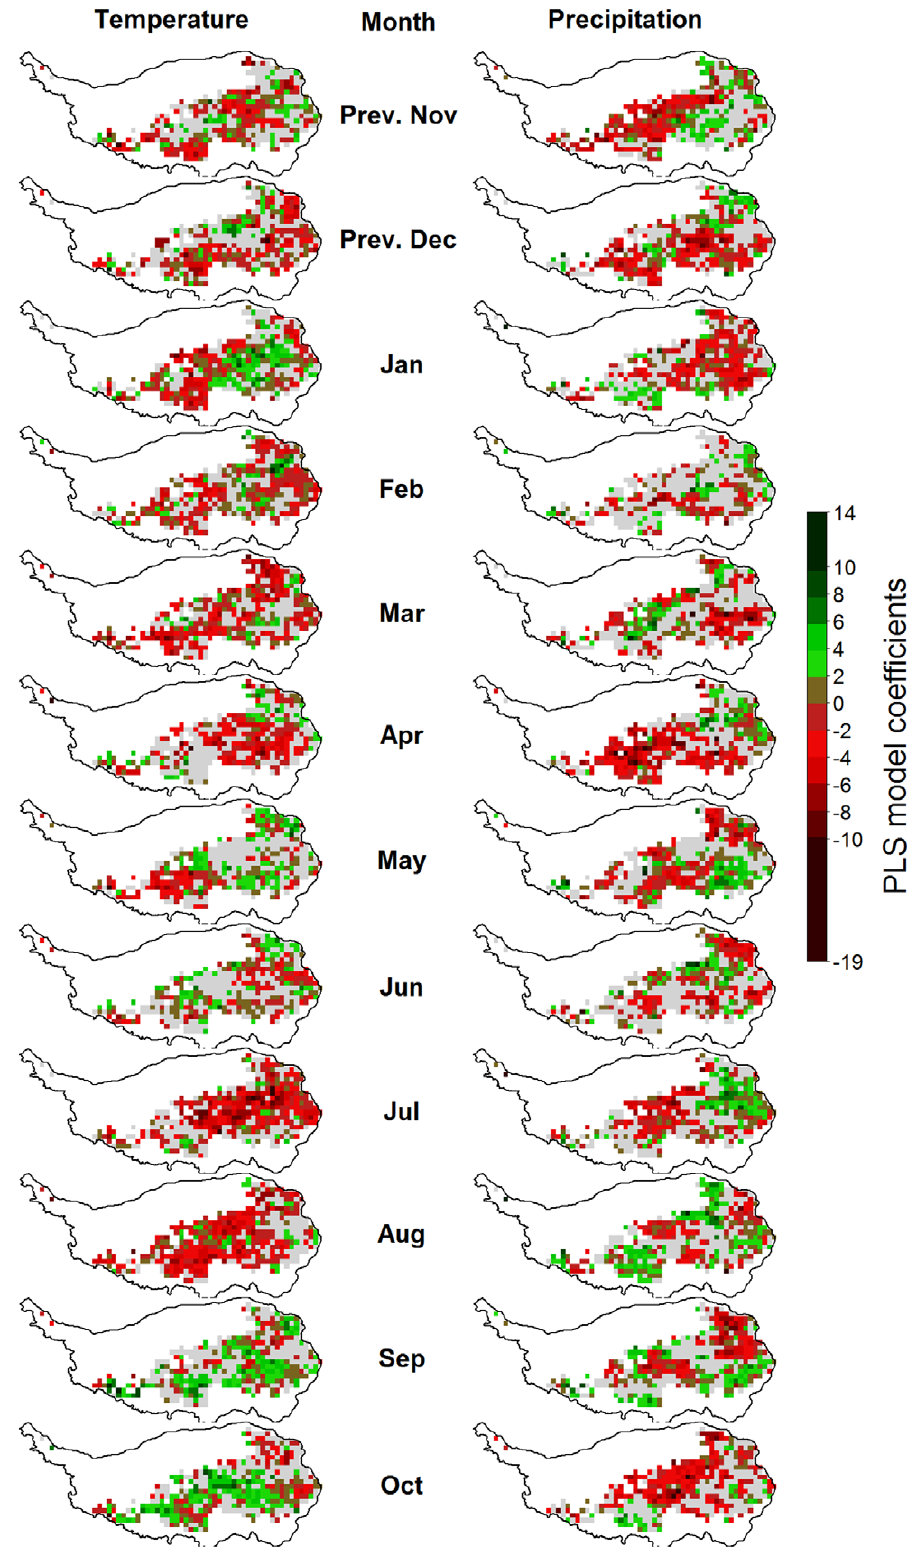
Figure 9. Correlations of monthly temperatures (left) and precipitation (right) with the timing of grassland senescence on the Tibetan Plateau, according to Partial Least Squares (PLS) regression. For each variable, pixels for which the variable-importance-in-the- projection score was , 0.8 are shown in gray. Pixels with insufficient data for PLS analysis are shown in white.